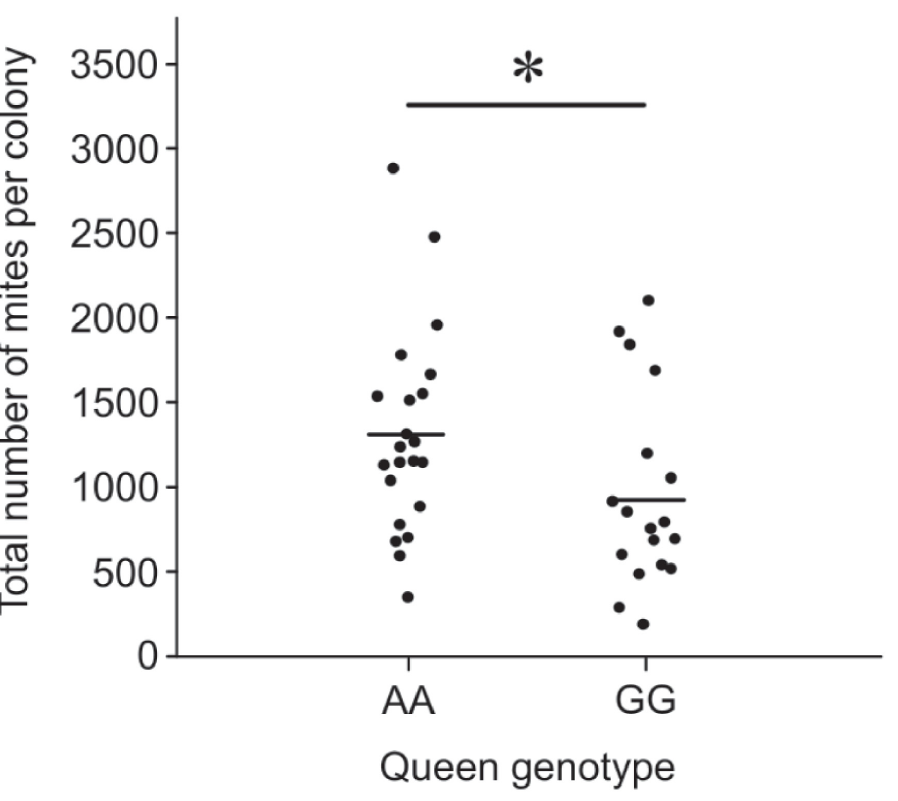
Fig 3. Total mite infestation of colonies headed by treatment (GG) and control (AA) queens at the end of the beehive trial. The mean of each data set is represented by a horizontal bar. Asterisks indicate significance between genotypes ( � P <